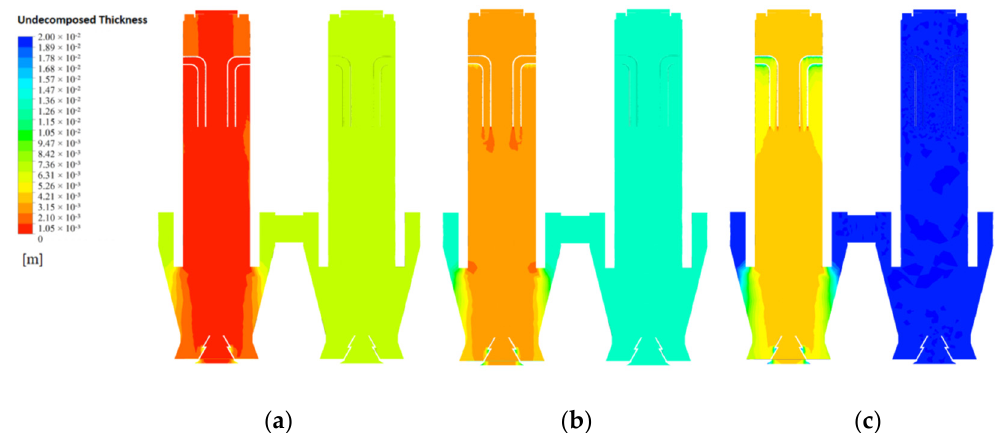
Figure 19. Distribution of undecomposed thickness of CaCO 3 at 40 mm, 80 mm and 120 mm particle sizes. ( a ) undecomposed thickness of CaCO 3 at 40 mm ( b ) undecomposed thickness of CaCO 3 at 80 mm ( c ) undecomposed thickness of CaCO 3 at 120 mm.